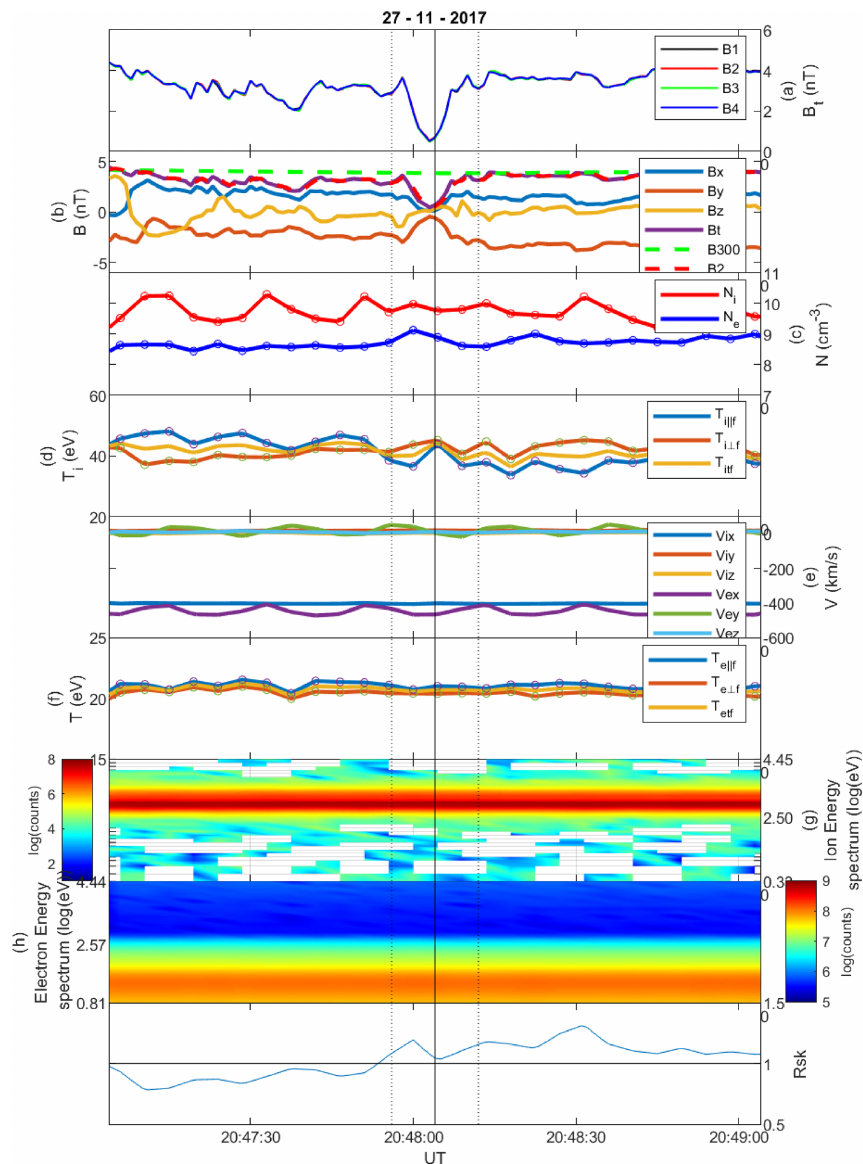
Figure 1. Linear magnetic hole on 27 November 2017, category cold. (a) The total magnetic field B t for all four MMS spacecraft. (b) The magnetic field components with B 300 and B 2 . (c) The fast-mode ion and electron density. (d) The parallel, perpendicular and total ion temperature in fast mode. (e) The fast-mode ion and electron velocity components. (f) The parallel, perpendicular and total electron temperature in fast mode. (g) The ion energy spectrogram. (h) The electron energy spectrogram. (i) The instability criterion R SK .